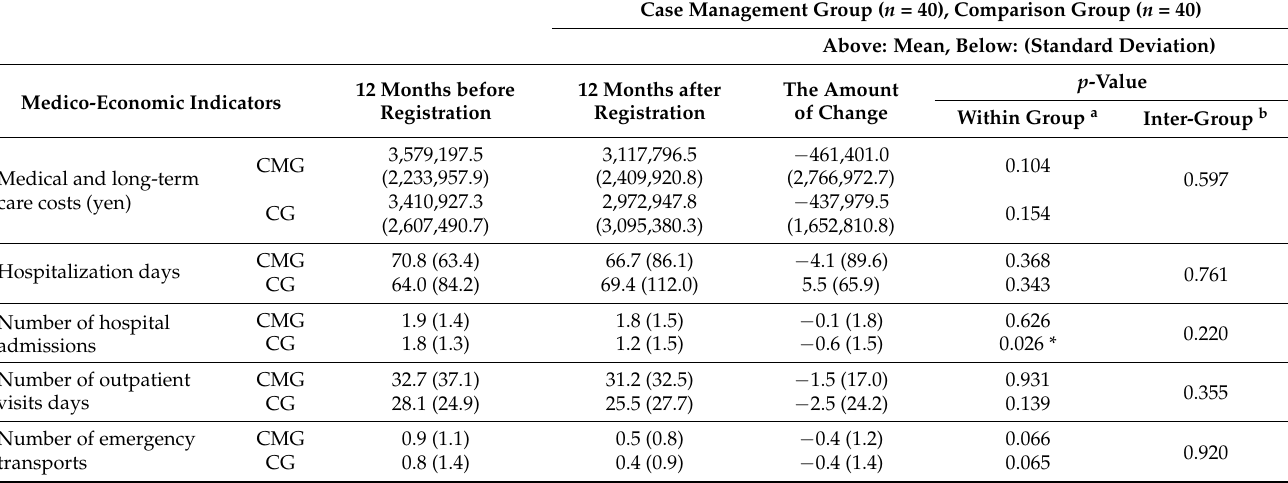
Table 3. Change from 12 months before to 12 months after the registration.